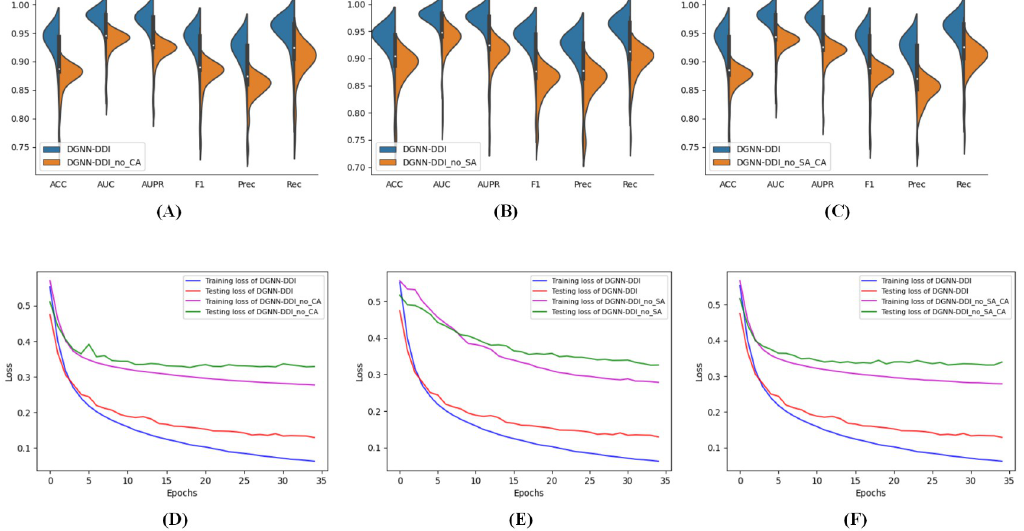
Fig 6. Analysis of the substructure attention mechanism (SA) and co-attention layer (CA). (A)-(C) The metric scores of DGNN-DDI and without SA and/or CA. (D)-(F) The training and testing losses for DGNN-DDI and without SA and/or